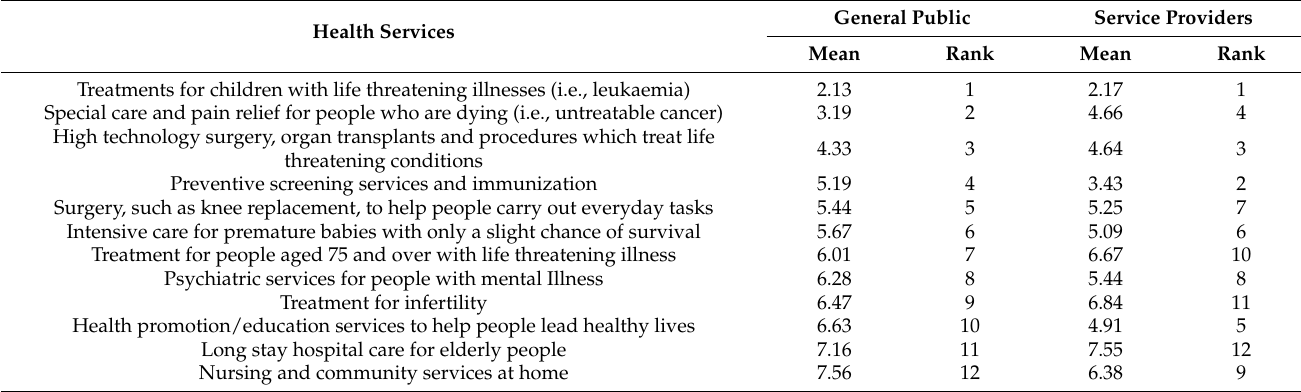
Table 5. Mean priority ranking of health services (1 = highest priority).